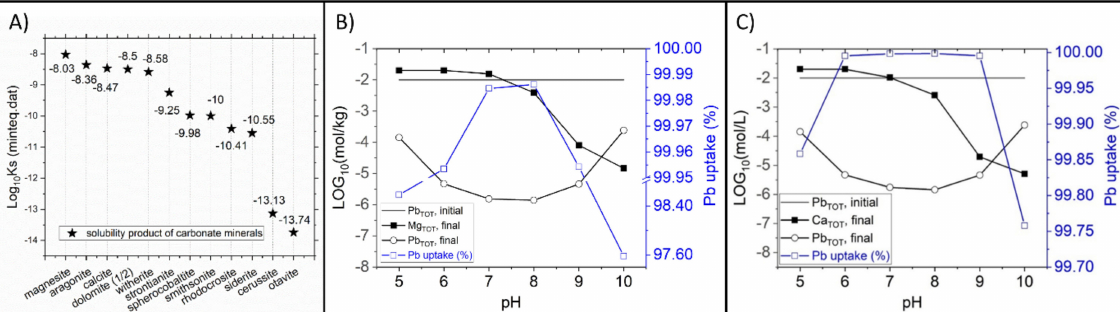
Figure 1. ( A ) Solubility product of anhydrous carbonate minerals from Minteq.dat. This database is included in Phreeqc and was used for the following simulations. ( B ) Phreeqc simulation showing the amount of Pb 2+ that can be precipitated by adding 0.02 mol (1.7 g) of magnesite to 1 L of a solution with an initial Pb 2+ concentration of 10 mM. ( C ) A similar Pb 2+ uptake is achieved using 0.02 mol (2 g) of calcite (notice the break in the right axis of Figure 1B). Analogous system behaviour is predicted for aragonite and dolomite as remediation agents. Among the contaminants, otavite (cadmium carbonate) shows a solubility even lower than cerussite (PbCO 3 ), thus Cd 2+ could also be efficiently taken up through this spontaneous